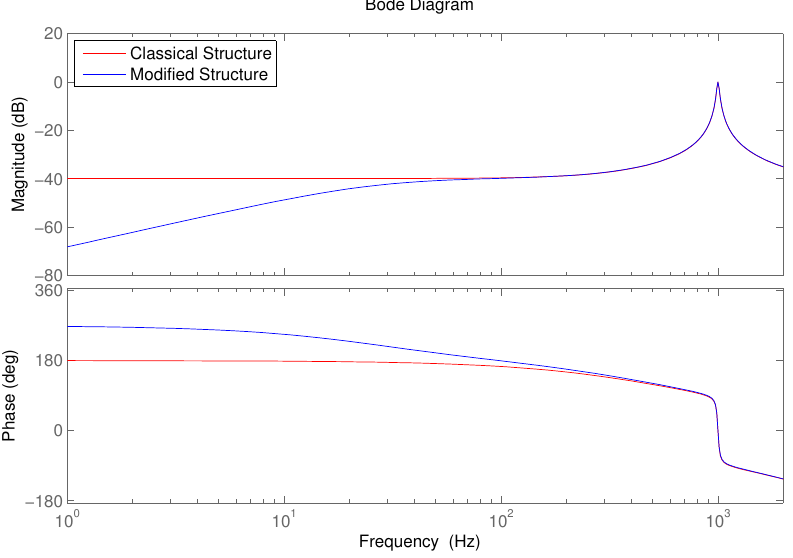
Figure 14. The magnitude-phase characteristic of H ( z ) and H (cid:48) ( z ) when C = 1, µ = 0.001: classical structure H ( z ) (red line); modified structure H (cid:48) ( z ) (blue